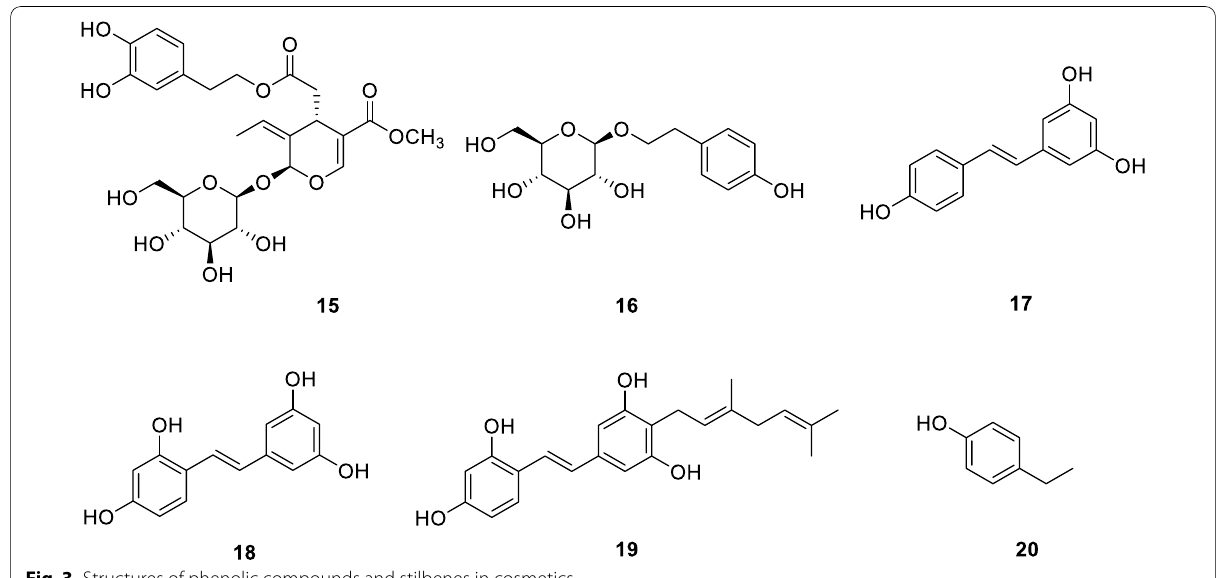
Fig. 3 Structures of phenolic compounds and stilbenes in